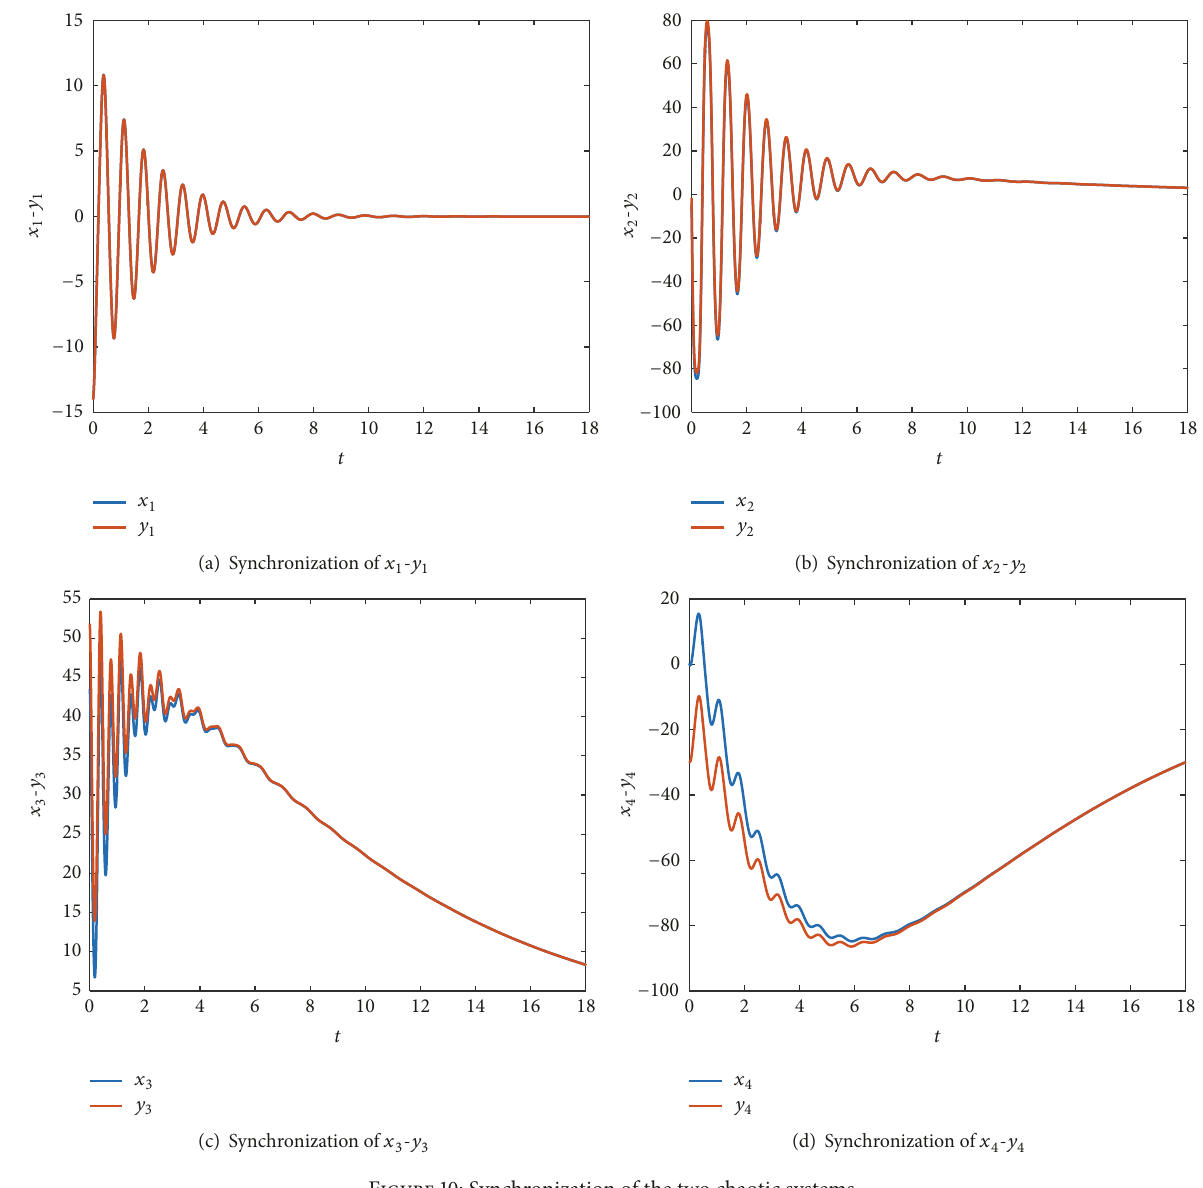
Figure 10: Synchronization of the two chaotic